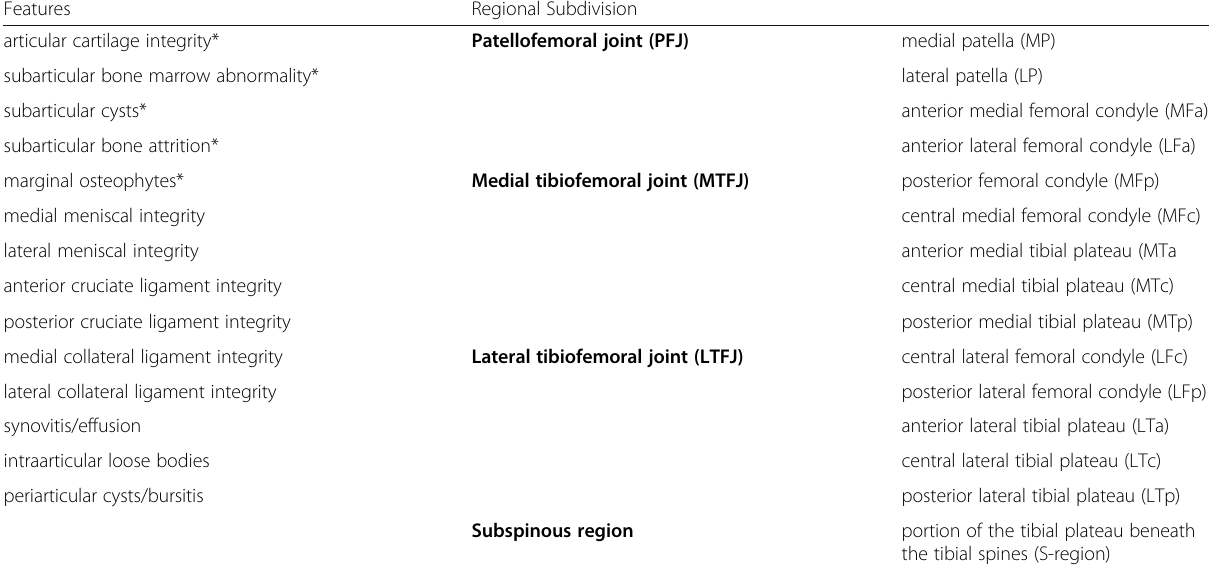
Table 1 WORMS features and regional subdivision of the knee joint. Features marked with * were evaluated in the different regions. Cartilage, bone attrition and osteophytes were not evaluated in the S-region Features